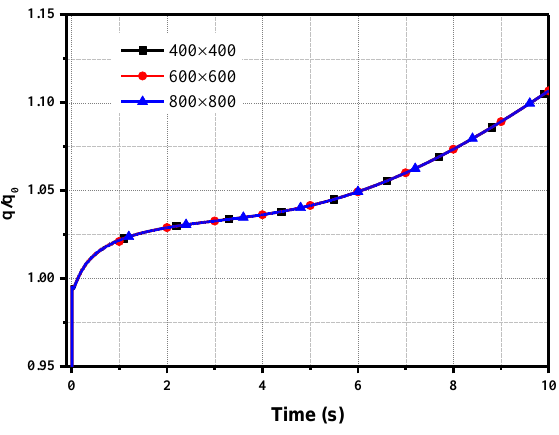
Figure 5. Junction heat flux for three grid resolutions.